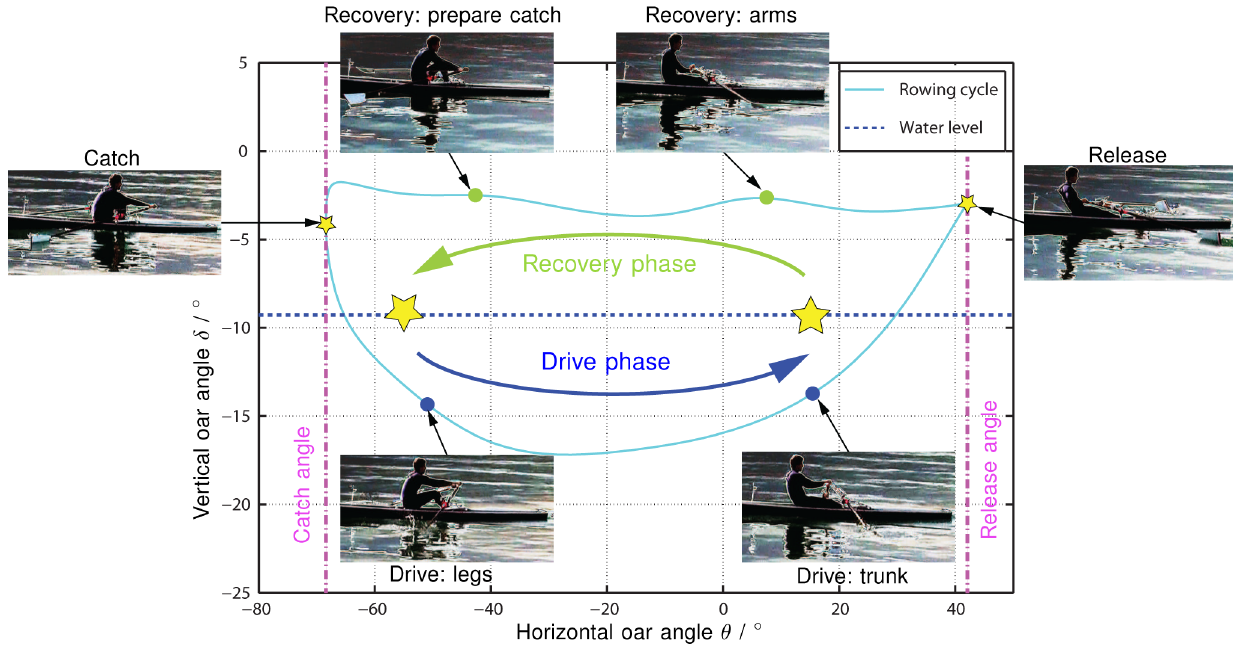
Figure 2. The phases of the rowing cycle. The rowing cycle is divided into two phases: the recovery phase, where the oar is in water and the drive phase, where the oar is pulled through water. The stars indicate the locations, where the phases are separated. These are the points, where the oar enters water (catch) and where the oar is lifted out of water (release).